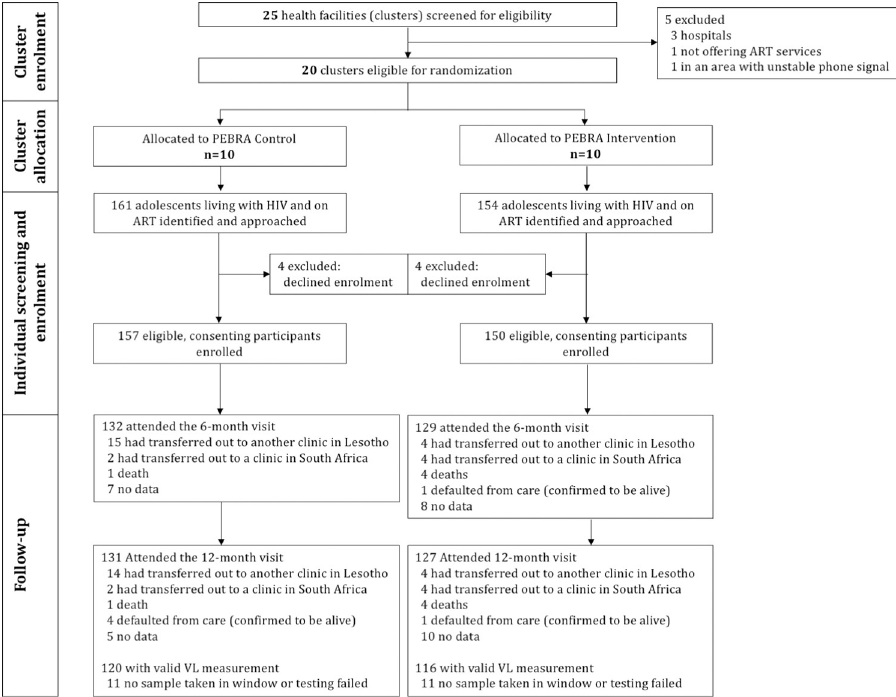
Fig 2. Consort flow diagram. ART, antiretroviral therapy; PEBRA, Peer Educator-Based Refill of ART;, VL, viral load.